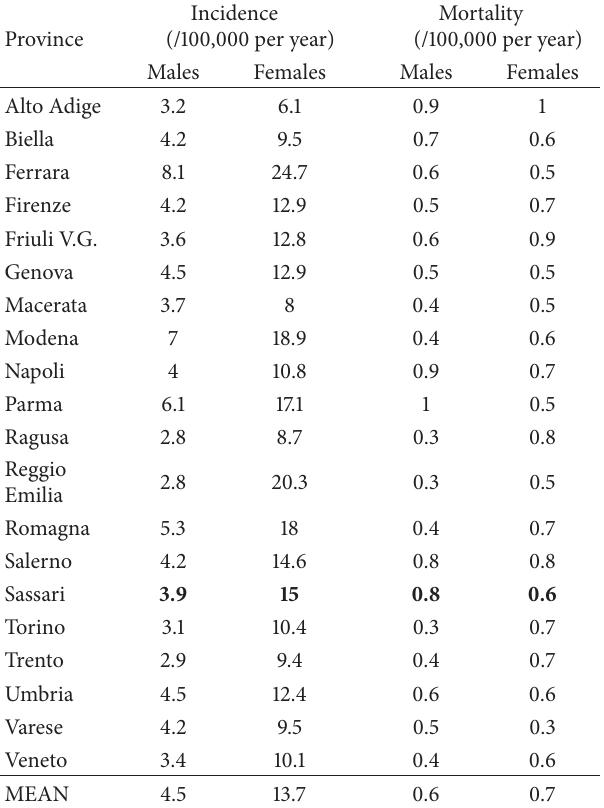
Table 3: Comparison with incidence and mortality rates of other Italian